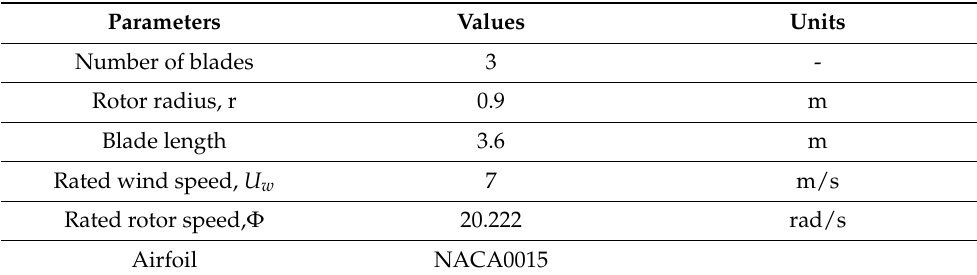
Table 5. Main parameters of the optimized